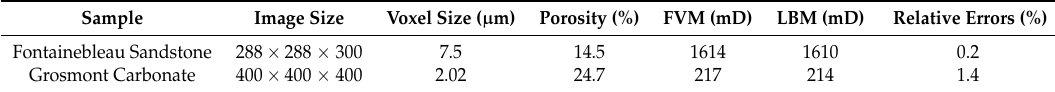
Table 3. Numerical Simulations Results of the Absolute Permeability in z